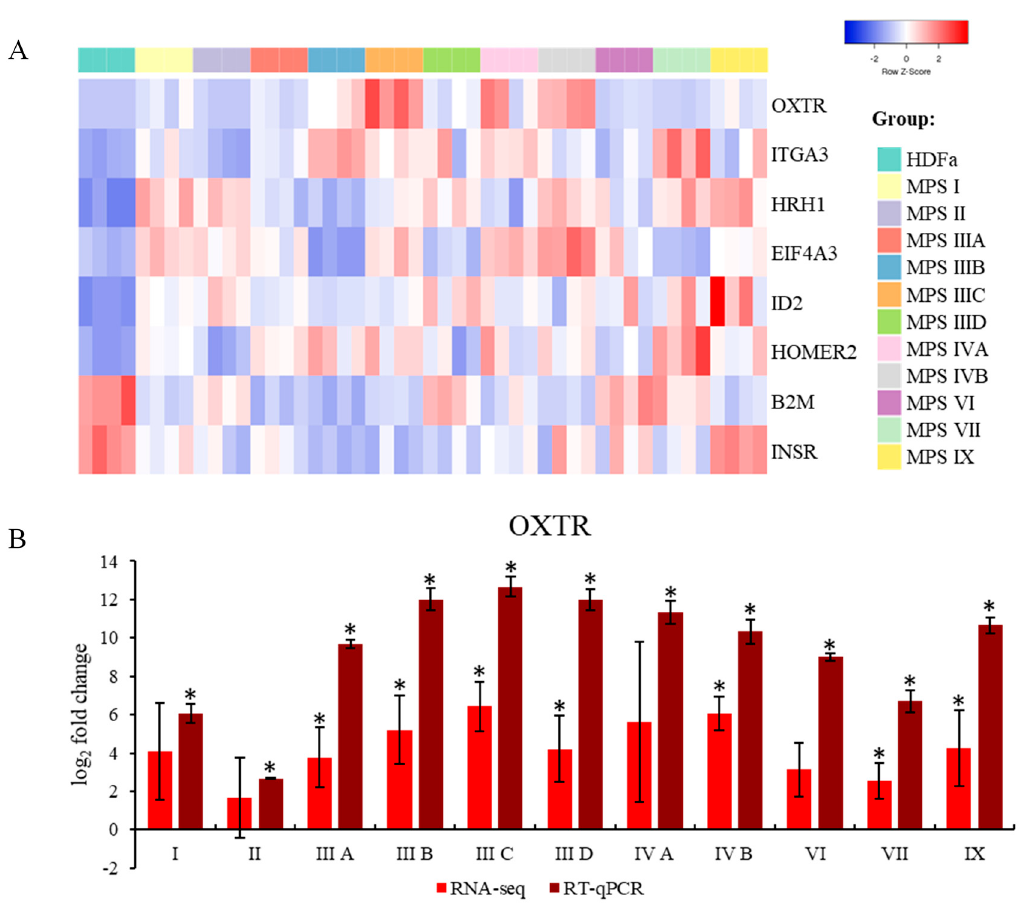
Figure 3. Genes which expression is significantly changed in at least six MPS types / subtypes relative to the control cells. Heat map of transcript levels is presented in panel ( A ) (MPS types and biological repeats are indicated). Comparison of results obtained for the OXTR gene using RNA-seq and RT-qPCR methods is shown in panel ( B ). Presented values are mean values from 4 experiments with SD shown as error bars. Statistically significant differences relative to control (HDFa) cells are indicated by asterisks.